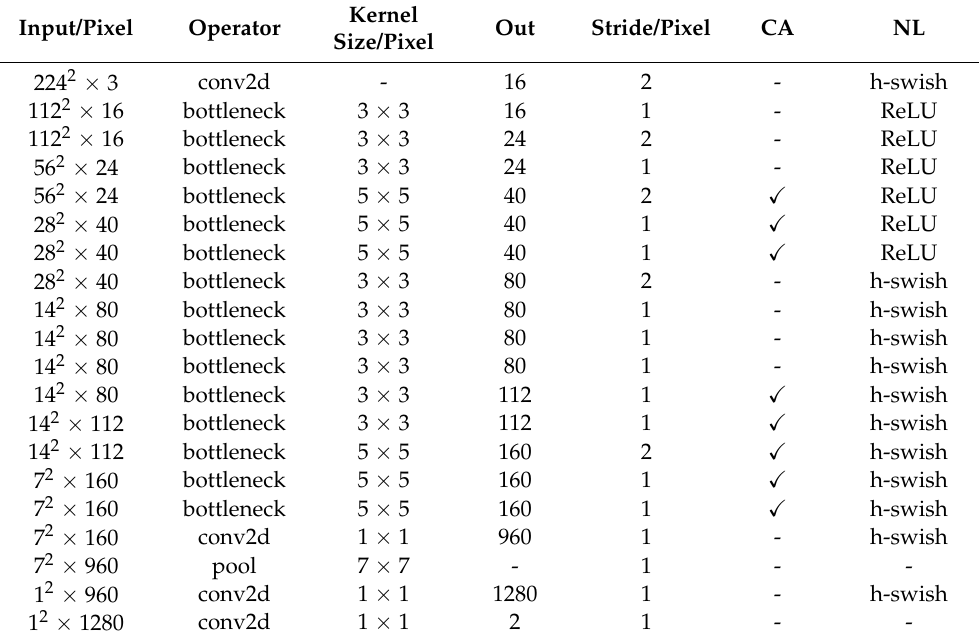
Table 1. Related operations and parameters of the improved